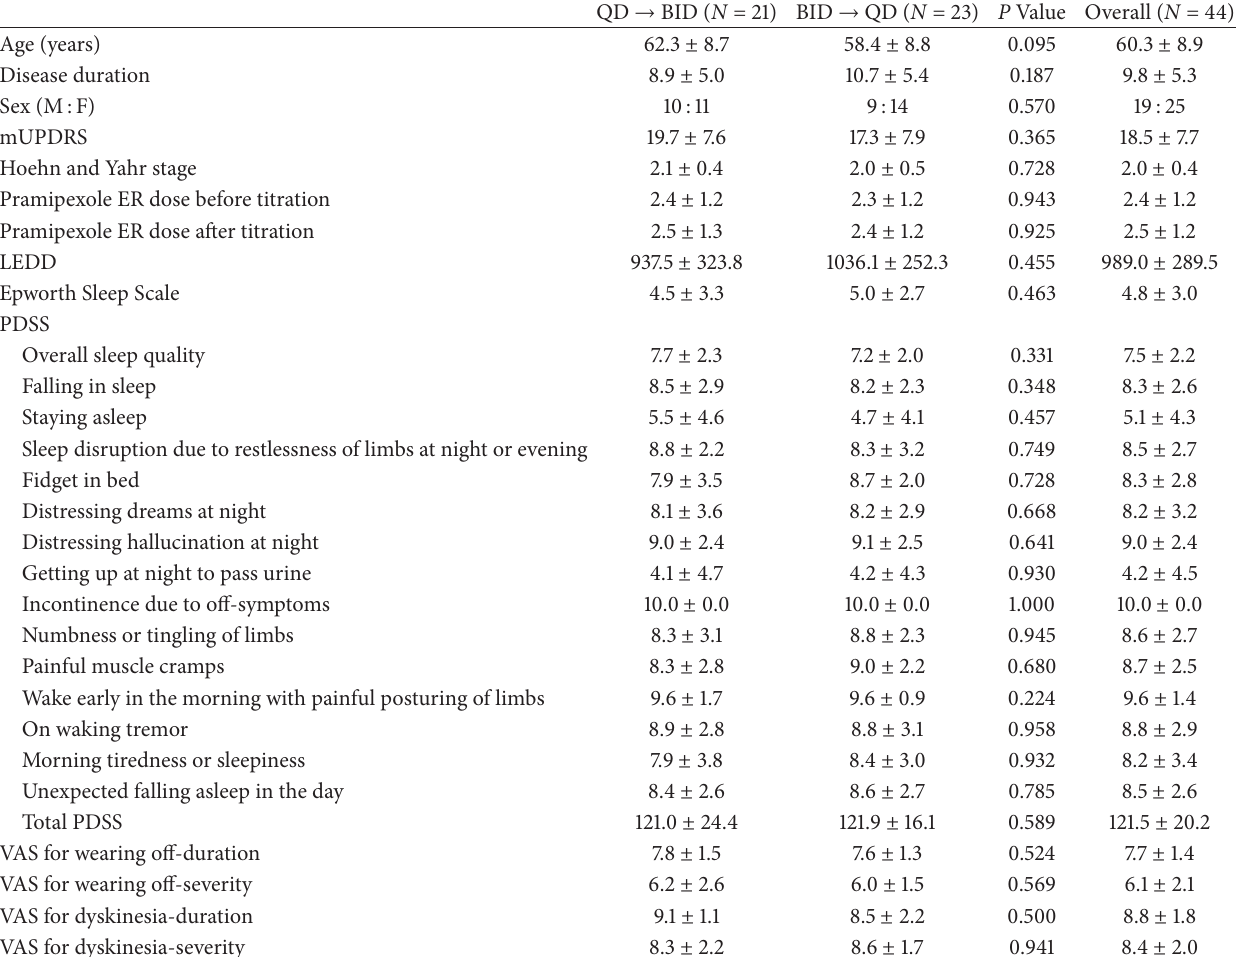
Table 1: Baseline characteristics in the per-protocol population.